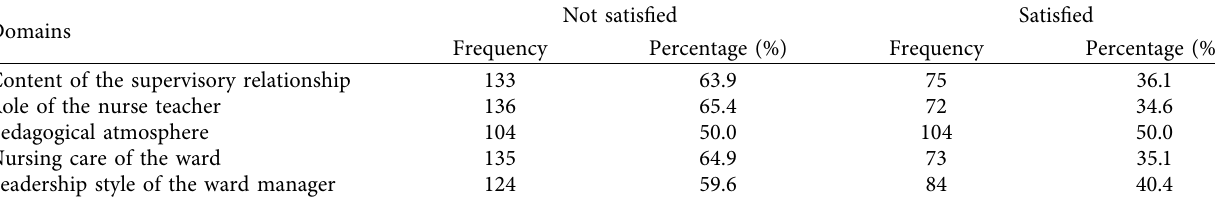
Table 2: Level of satisfaction towards CLE among study